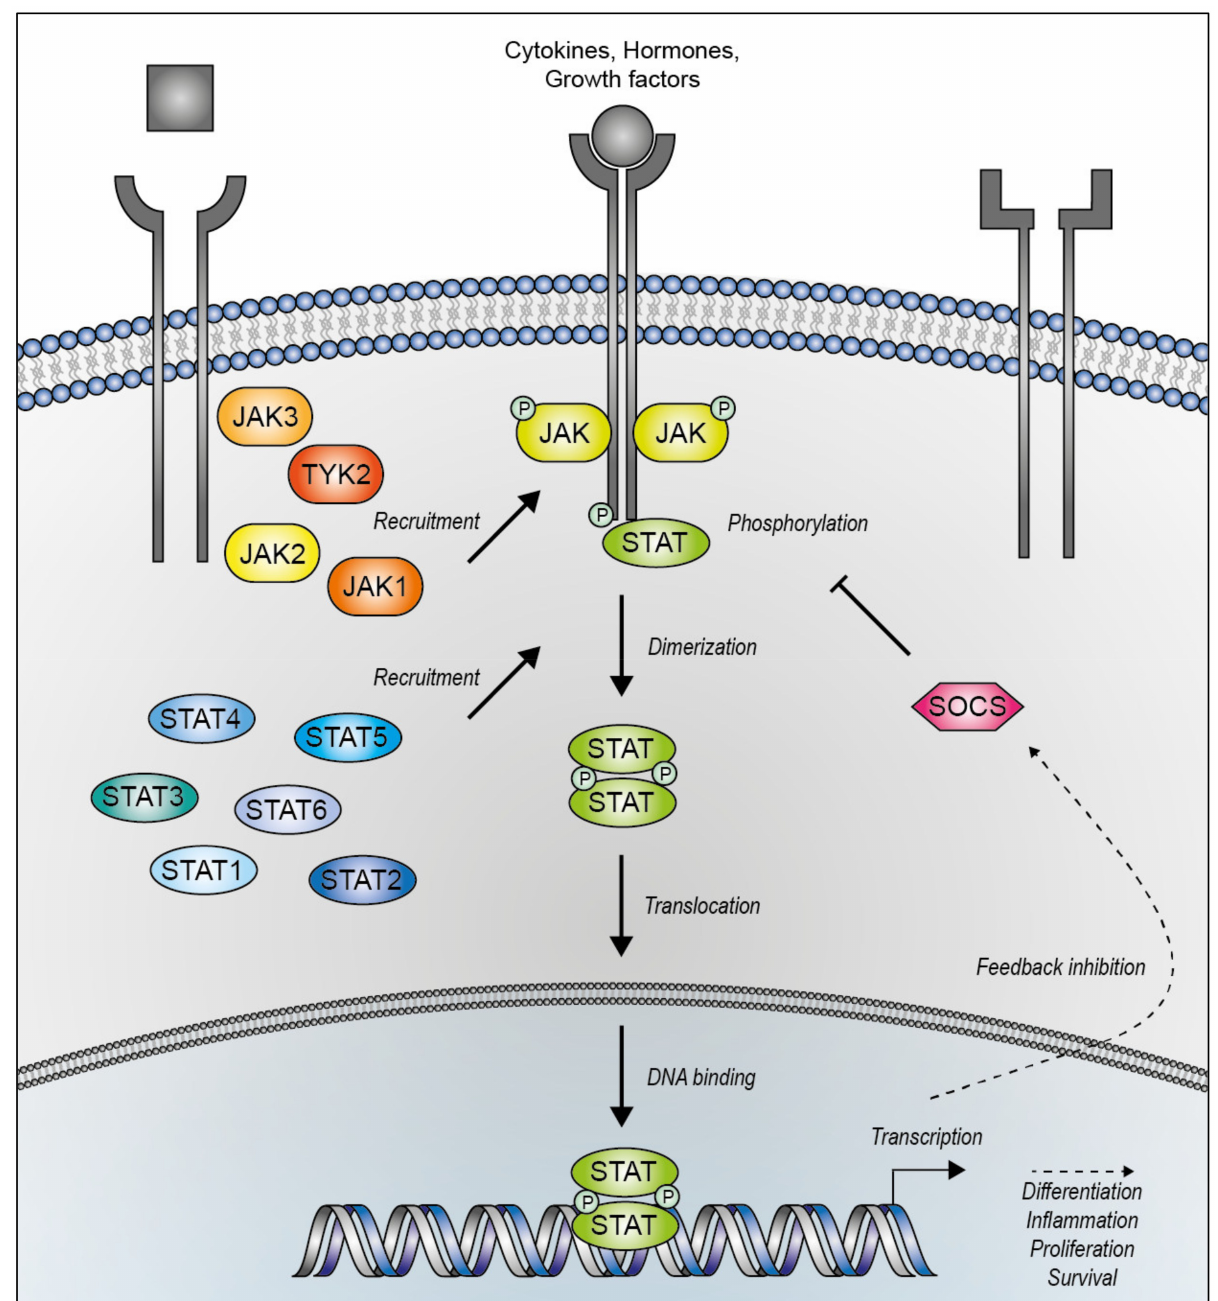
Figure 1. The JAK-STAT signaling pathway. The JAK-STAT pathway transmits signals from extracellular ligands (e.g., cy- tokines: IL-2, IL-3, IL-4, IL-5, IL-6, IL-7, IL-9, IL-10, IL-11, IL-12, IL-13, IL-15, IL-20, IL-21, IL-22, IL-23, IL-24, IL27, IL-31, IFN α , IFN β , IFN γ , IFN λ , GM-CSF, G-CSF, leptin; hormones: EPO, PRL, GH, TPO; growth factors: EGF, insulin, FGF, PDGF, VEGF) through an intracellular signaling cascade to the transcriptional machinery in the nucleus.